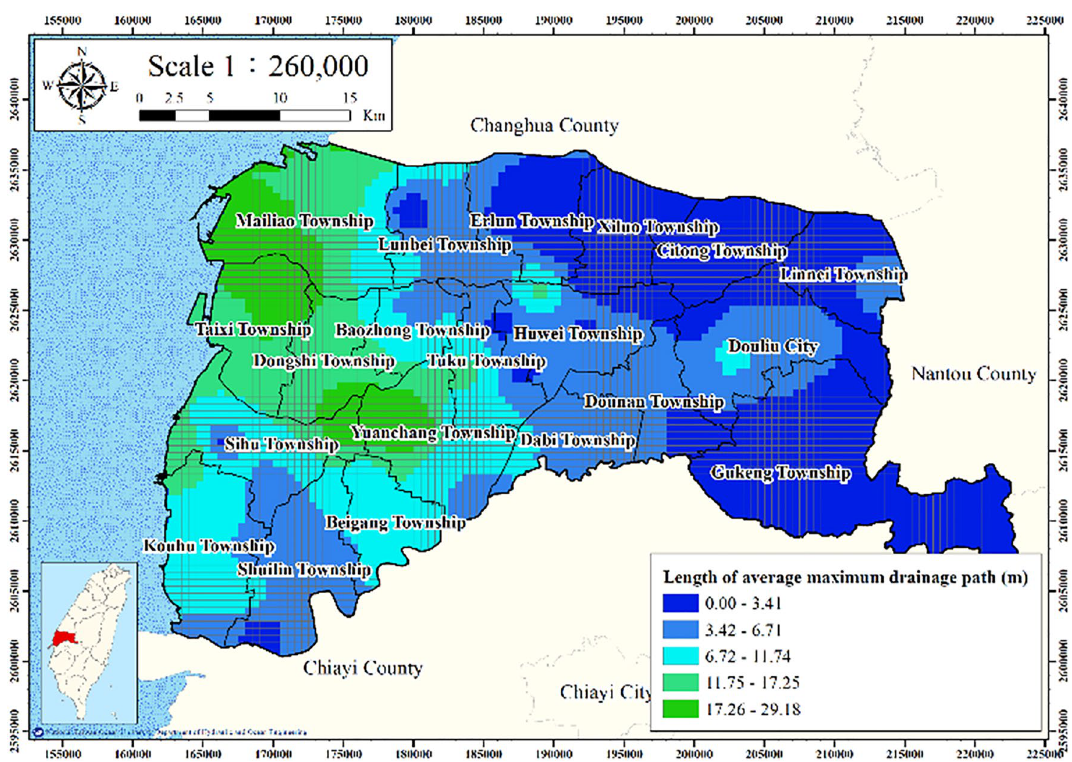
Figure 14. Cells of average maximum drainage path length. This figure was created using ArcGIS 10.6.1